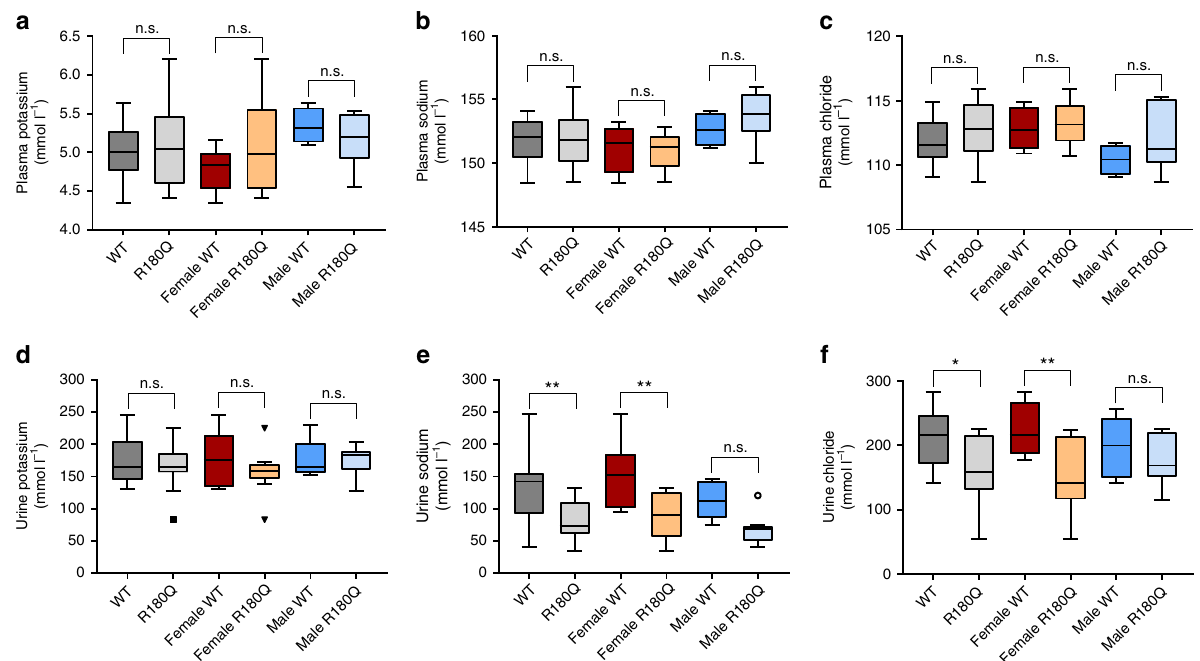
Fig. 6 Plasma and urine electrolyte levels. Plasma levels of potassium ( a ) (WT: N = 10; Clcn2 R180Q/ + : N = 16; P = 0.9315; female WT: N = 6; female Clcn2 R180Q/ + : N = 10; P = 0.5490; male WT: N = 4; male Clcn2 R180Q/ + : N = 6; P = 0.9161; one-way ANOVA including Sidak´s MCP; F = 1.02; df = 46), sodium ( b ) (WT: N = 10; Clcn2 R180Q/ + : N = 16; P = 0.9854; female WT: N = 6; female Clcn2 R180Q/ + : N = 10; P = 0.9956; male WT: N = 4; male Clcn2 R180Q/ + : N = 6; P = 0.7652; one-way ANOVA including Sidak´s MCP; F = 0.4119; df = 46) and chloride ( c ) (WT: N = 10; Clcn2 R180Q/ + : N = 16; P = 0.5559; female WT: N = 6; female Clcn2 R180Q/ + : N = 10; P = 0.9658; male WT: N = 4; male Clcn2 R180Q/ + : N = 6; P = 0.4857; one-way ANOVA